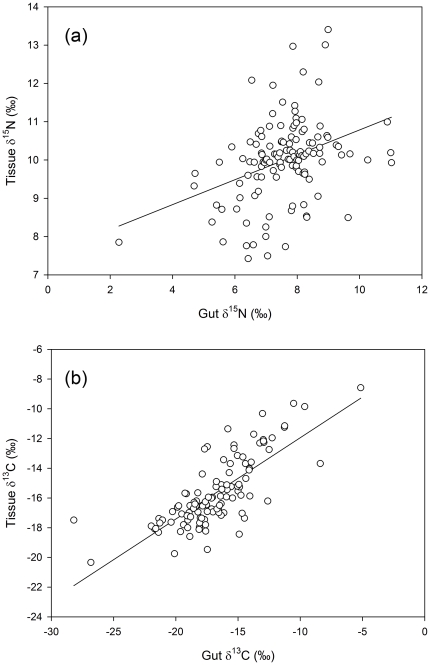
Discrimination factors versus tissue isotopic composition.Data is shown for (a) nitrogen (ΔN vs. δ15N, n = 126) and (b) carbon (ΔC vs. δ13C, n = 111 ). Solid line represents a significant linear regression relationship for nitrogen (ΔN = 0.574×δ15N–3.32; r2 = 0.226; F[1,124] = 36.23, p<0.001). There was no relationship for carbon (r2 = 0.005; F[1,109] = 0.0569, p = 0.452).